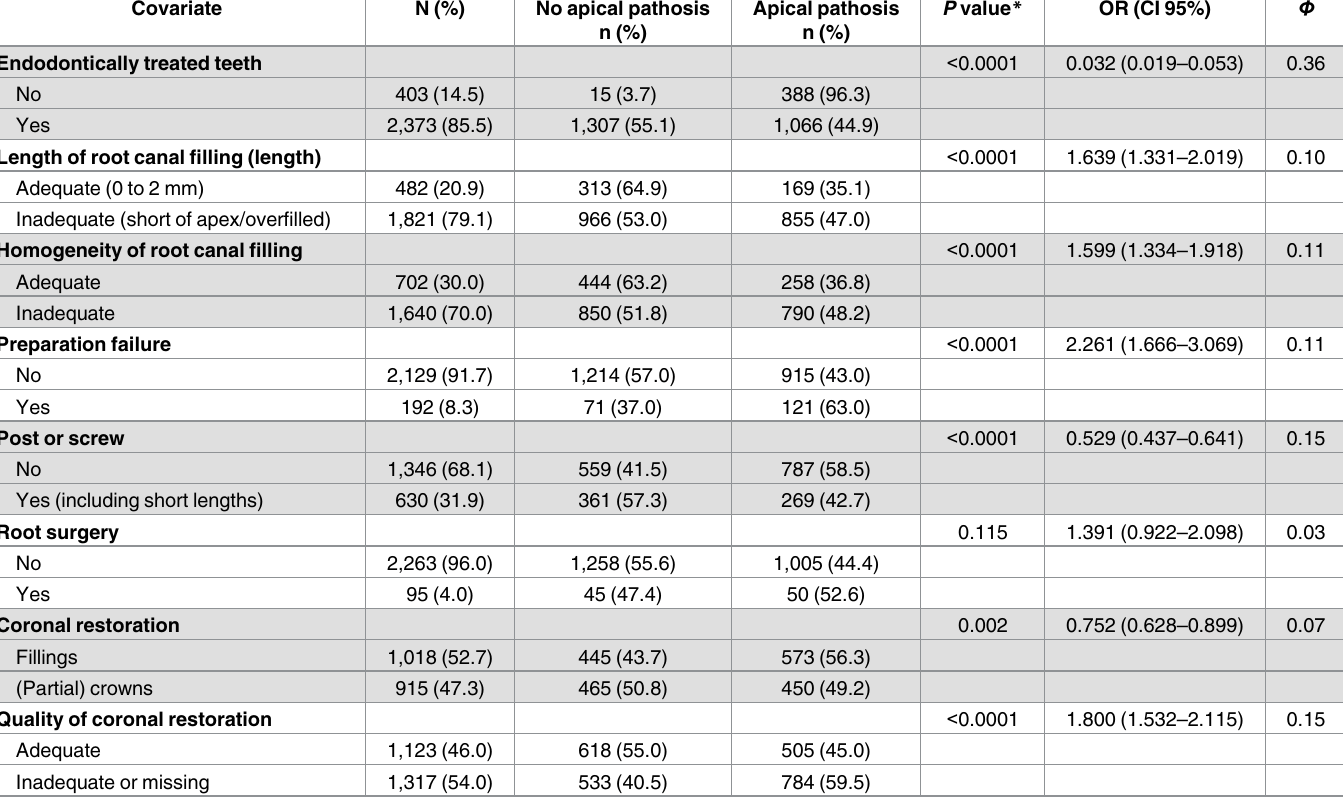
Table 4. Periradicular status in relation to various